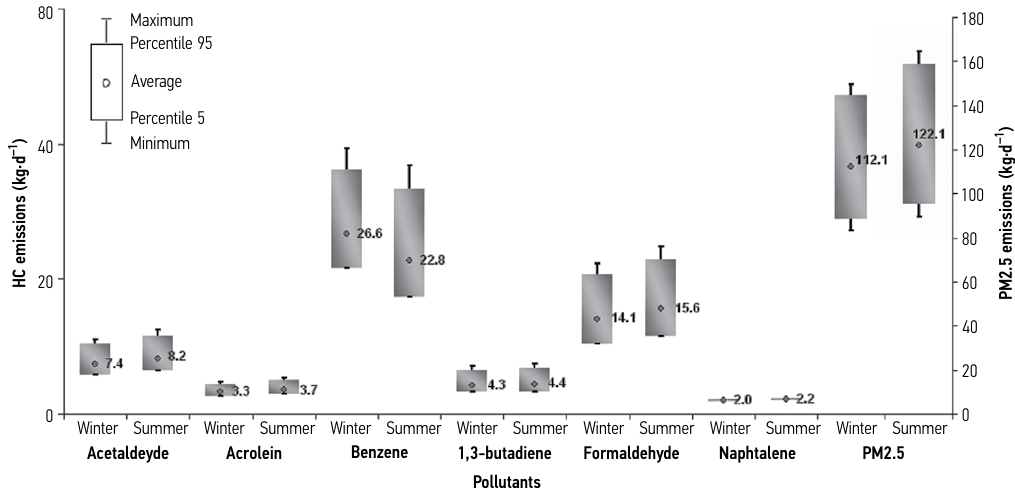
Fig. 6. Statistical parameters for total daily emissions in the Porto Urban Area considering winter and summer